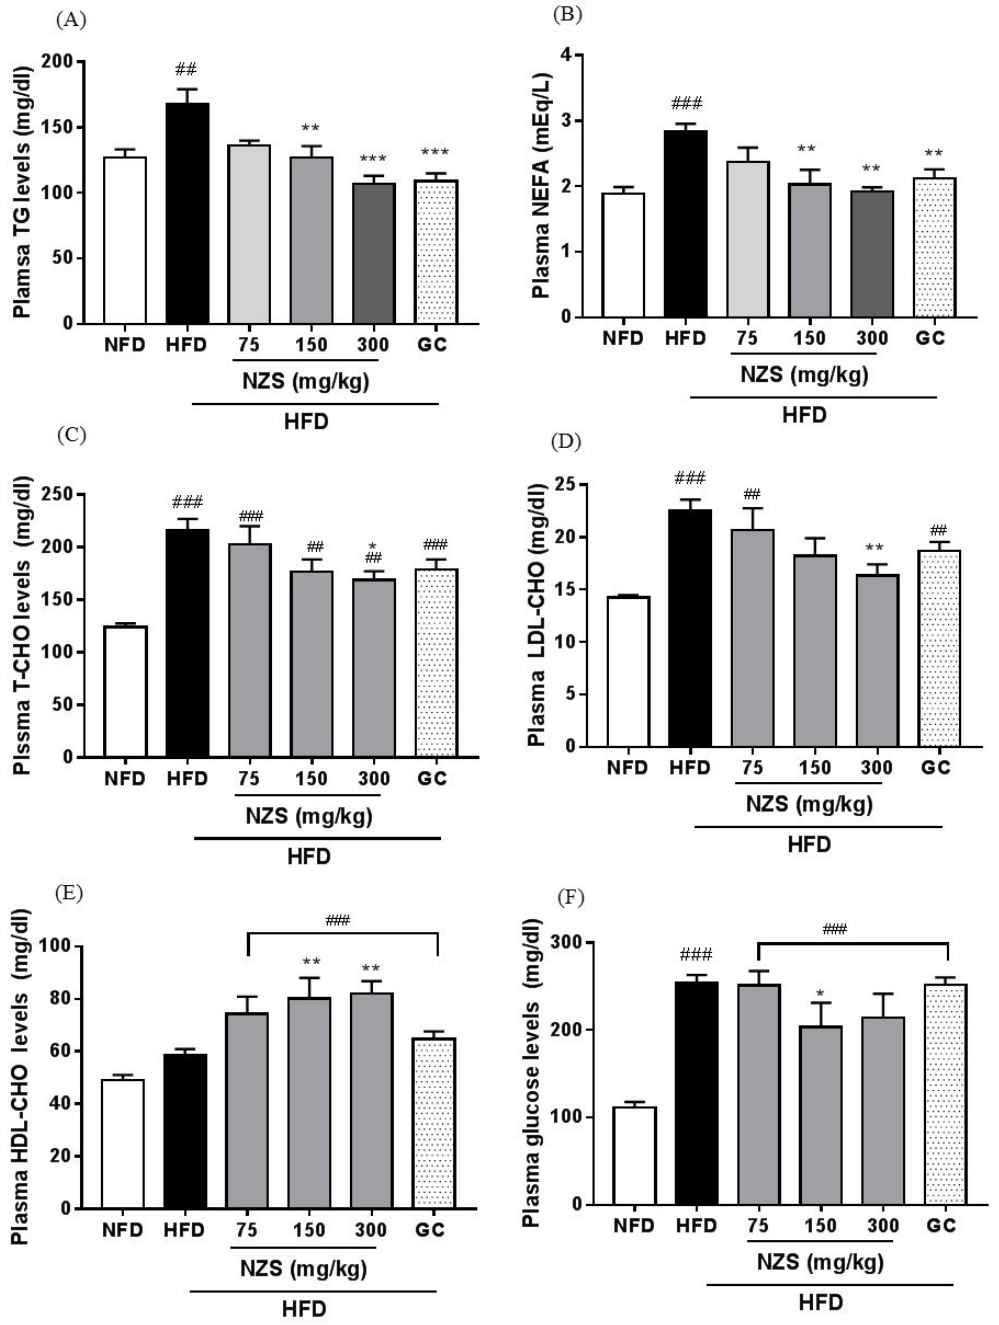
Figure 5. Effects of NZS on biochemical parameters in HFD-induced obese mice. ( A ) TG, ( B ) NEFA, ( C ) T-CHO, ( D ) LDL-CHO, ( E ) HDL-CHO, and ( F ) glucose. NFD: normal-fat diet; HFD: high-fat diet; NZS: Tetragonia tetragonoides (Pall.) Kuntze extract (New Zealand spinach); GC: Garcinia cambogia extract. Values are expressed as mean ± SEM ( n = 5). ## p < 0.01 and ### p < 0.005 versus the NFD group; * p < 0.05, ** p < 0.01, and *** p < 0.005 versus the HFD group.